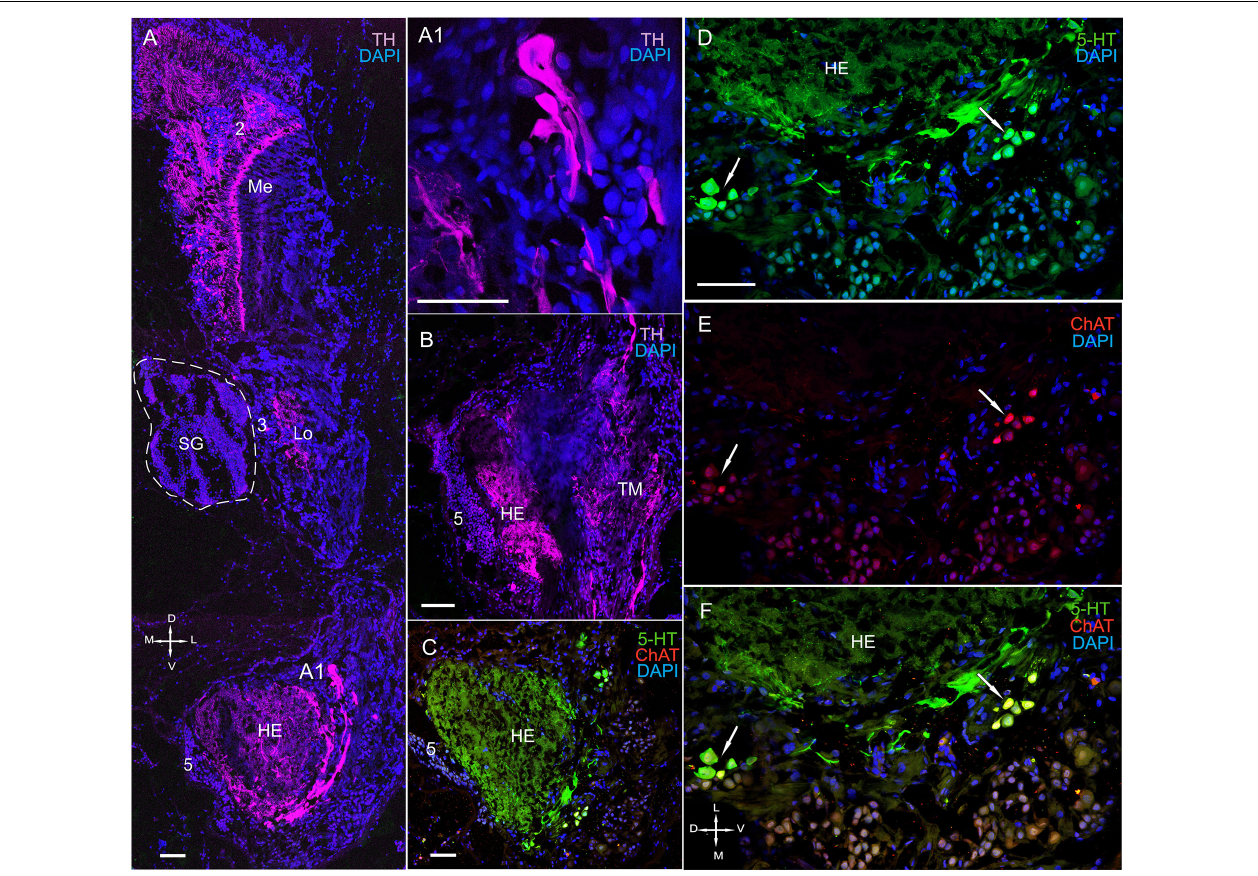
FIGURE 10 | Immunolocalization of 5-HT, TH, and ChAT in the optic neuropils, SG, and lateral protocerebrum. (A) Tissue section showing high levels of TH-positive immunostaining in the Me, Lo, and LP. (A1) TH-positive cells with large varicose processes in the LP. (B) High levels of TH in processes of both the HE and the TM. (C) ChAT- and 5-HT-positive immunostaining in the HE and neurons in different regions of the TM. (D–F) Double immunolabeling of 5-HT and ChAT in neurons of the TM. Green, 5-HT; red, ChAT; magenta, TH; blue, DAPI. Scale bars = 100 µ m. Me, medulla; Lo, lobula; HE, hemiellipsoid body; TM, terminal medulla; PT, protocerebral tract; 2, 3, 5 (ds), cell cluster; D, dorsal; V, ventral; L, lateral; M, medial; A, anterior; P,